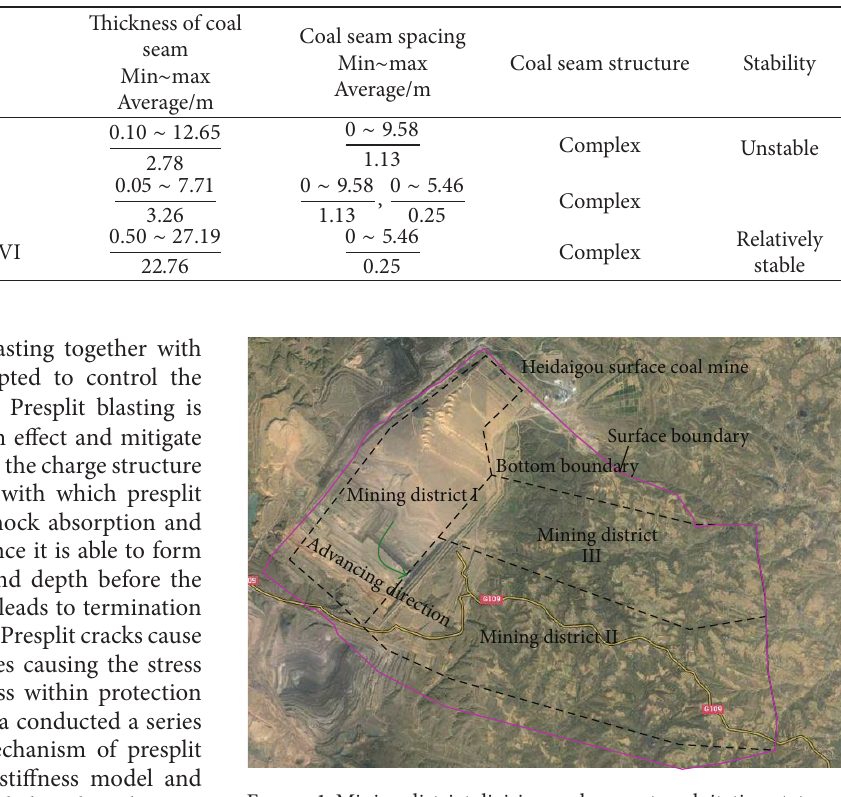
Figure 1: Mining district division and current exploitation status of Heidaigou open cast